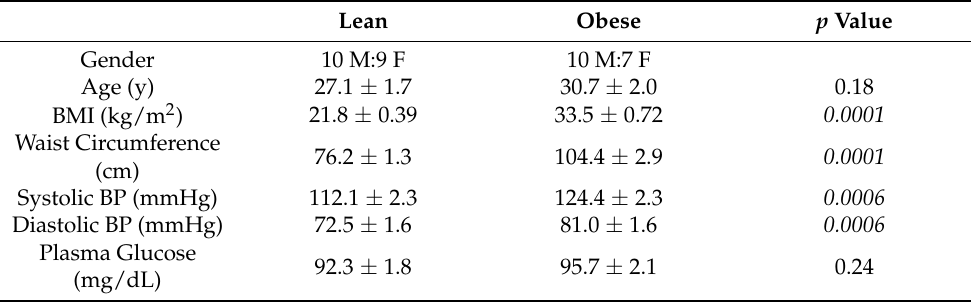
Table 1. Characteristics of lean and obese persons who completed a pharmacokinetics trial. Lean Obese p